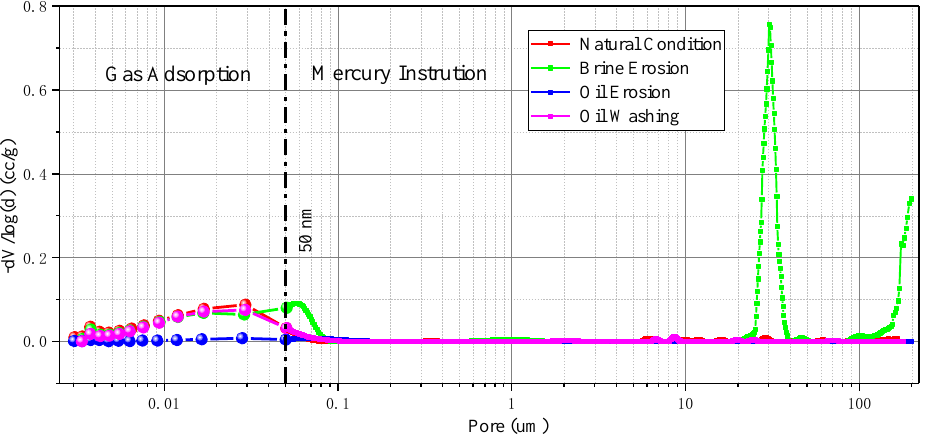
Figure 14. The total pore size distribution of cap rock samples under different conditions.